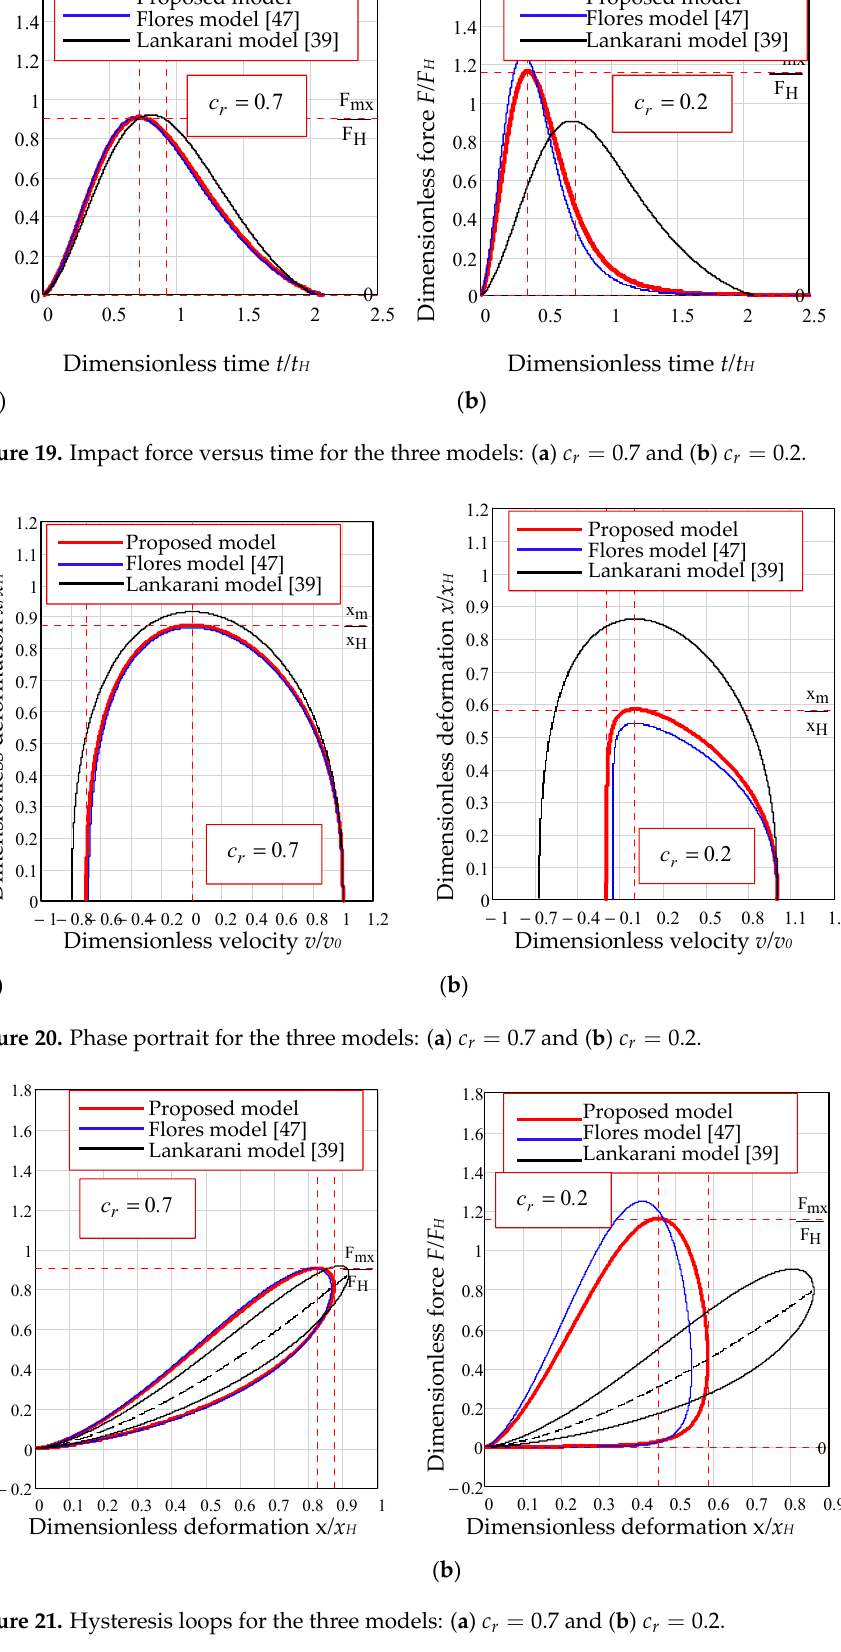
Figure 21. Hysteresis loops for the three models: ( a ) 𝑐 (cid:3045) = 0.7 and ( b ) 𝑐 (cid:3045) = 0.2 . From the presented figures, one can conclude that, for values of coefficient of restitu- tion, 𝑐 (cid:3045) ≥ 0.7 , all three models give similar results, while for smaller values, 𝑐 (cid:3045) < 0.7 , the current model and the Flores model present close results of the characteristic parameters